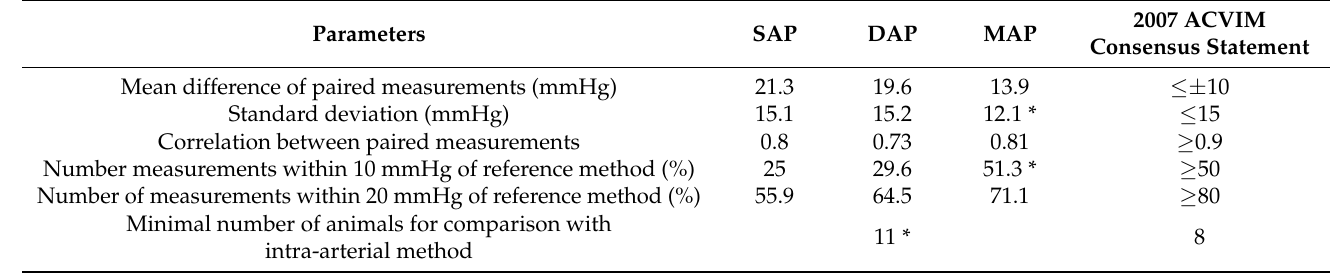
Table 1. Compliance with the American College of Veterinary Internal Medicine (ACVIM) consensus guidelines. Comparison of the invasively (IBP) and non-invasively (high-definition oscillometry (HDO)), measured systolic arterial pressure (SAP), diastolic arterial pressure (DAP), and mean arterial pressure (MAP) obtained at the metatarsal artery (MA) in 11 anaesthetised horses with validation criteria for blood pressure devices proposed by the ACVIM consensus statement